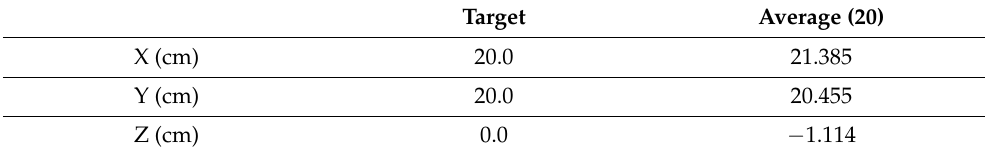
Table 1. The total average of the target distance and the action generated by the